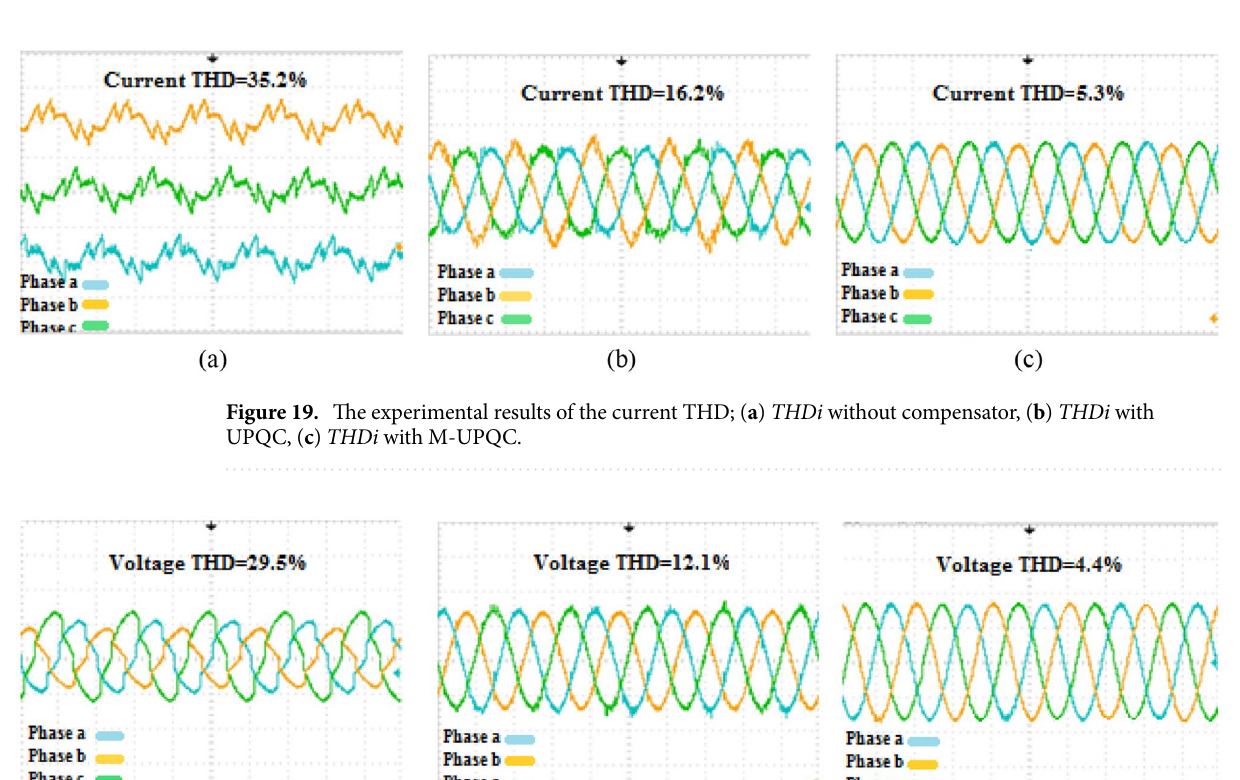
Figure 18. The experimental results of the voltage unbalance; ( a ) without compensator, ( b ) with M-UPQC.